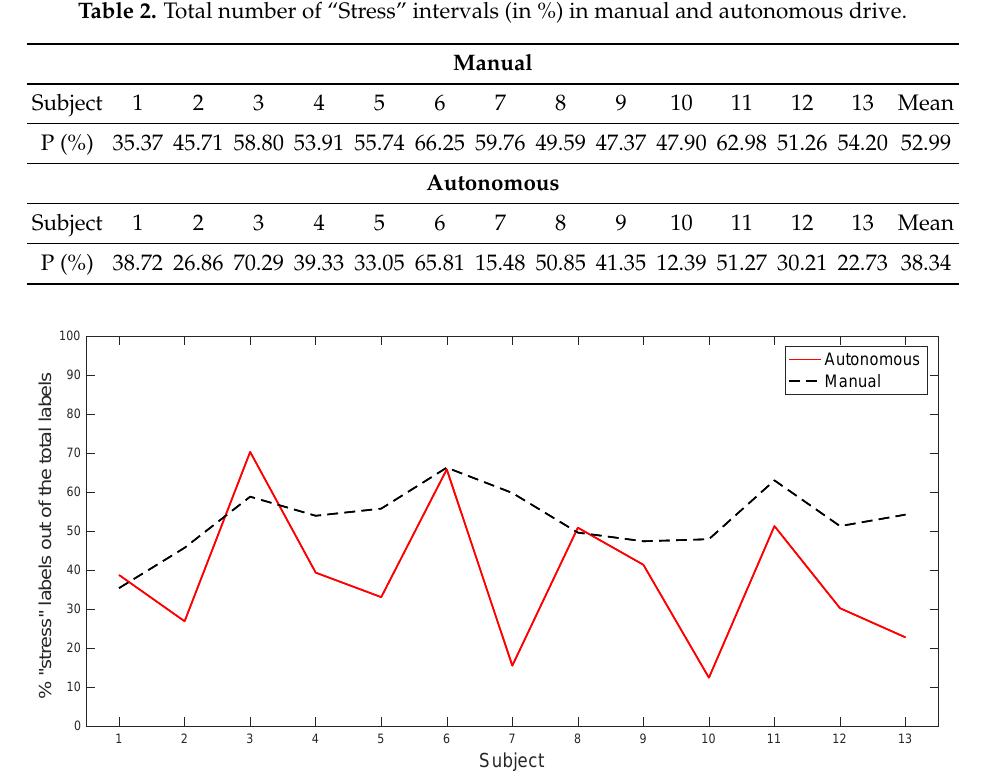
Figure 11. Total number of “stress” labeled intervals for each subject (in %), considering the whole test